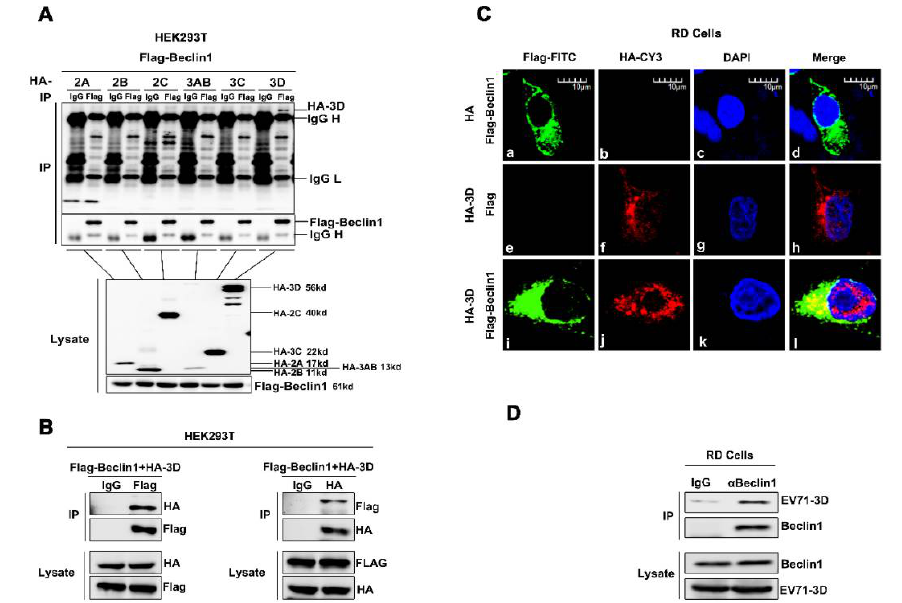
Figure 4. EV71 3D interacts and co-localizes with Beclin1 in the cytoplasm. ( A ) HEK293T cells were co-transfected with plasmid encoding Flag-Beclin1, and plasmids encoding EV71 non-structure proteins, HA-2A, HA-2B, HA-2C, HA-3AB, HA-3C and HA-3D, for 36 h, respectively. The cell lysates were immunoprecipitated with control IgG or an anti-Flag antibody, and then immunoblotted with the indicated antibodies. ( B ) HEK293T cells were co-transfected with plasmids encoding HA-3D and Flag-Beclin1. The cell lysates were immunoprecipitated with control IgG or an anti-Flag antibody or anti-HA antibody, and then immunoblotted with the indicated antibodies. ( C ) RD cells were transfected with plasmids encoding Flag-Beclin1 alone or HA-3D alone or co-transfected with Flag-Beclin1 and HA-3D for 24 h. The localization and distribution of Flag-Beclin1 protein (green), EV71 3D protein (red), and the nuclei (blue) were visualized under Laser scanning confocal microscope. Bar = 10 µ m. ( D ) RD cells were infected with EV71 (MOI = 2) for 12 h, and the cells were lysed and immunoprecipitated with control IgG or an anti-Beclin1 antibody and then immunoblotted with indicated antibodies.